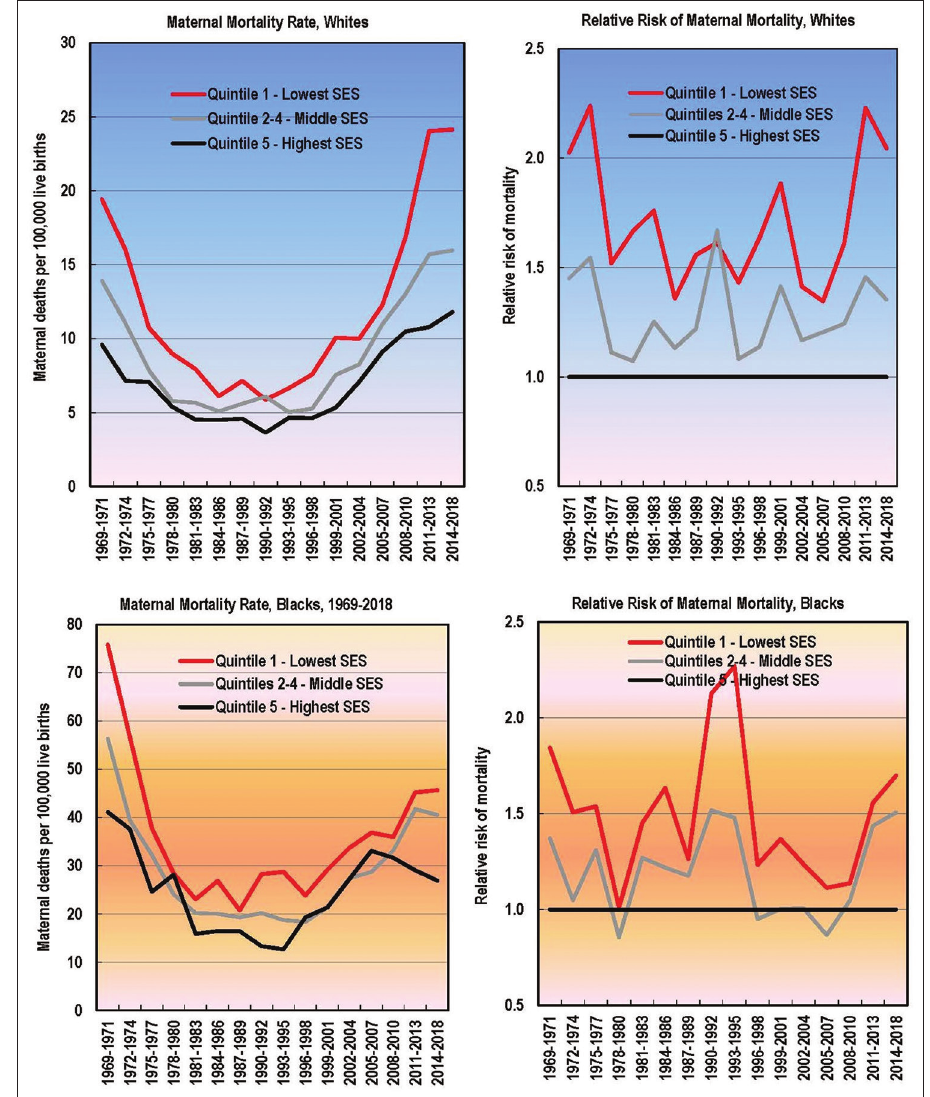
Figure 4 : Maternal Mortality among White and Black Women by Area Deprivation Index,